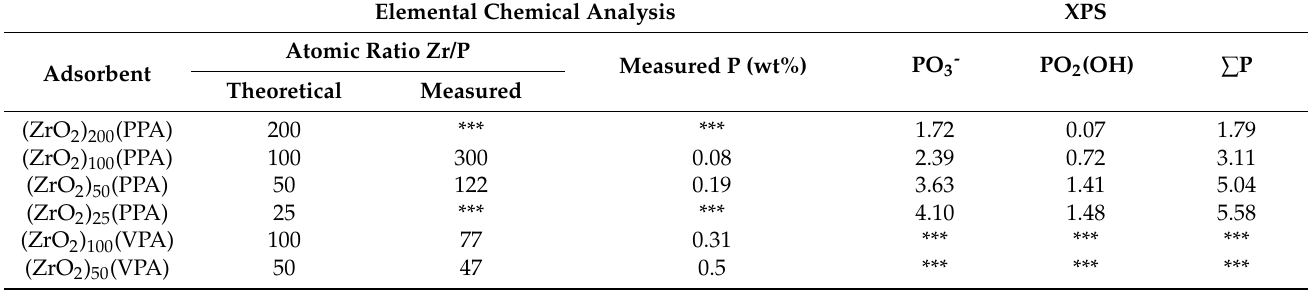
Table 1. Quantitative analysis of (ZrO 2 ) x (VPA) and (ZrO 2 ) x (PPA) nanocomposites using XPS and elemental chemical analysis. (*** = not done) Elemental Chemical Analysis XPS